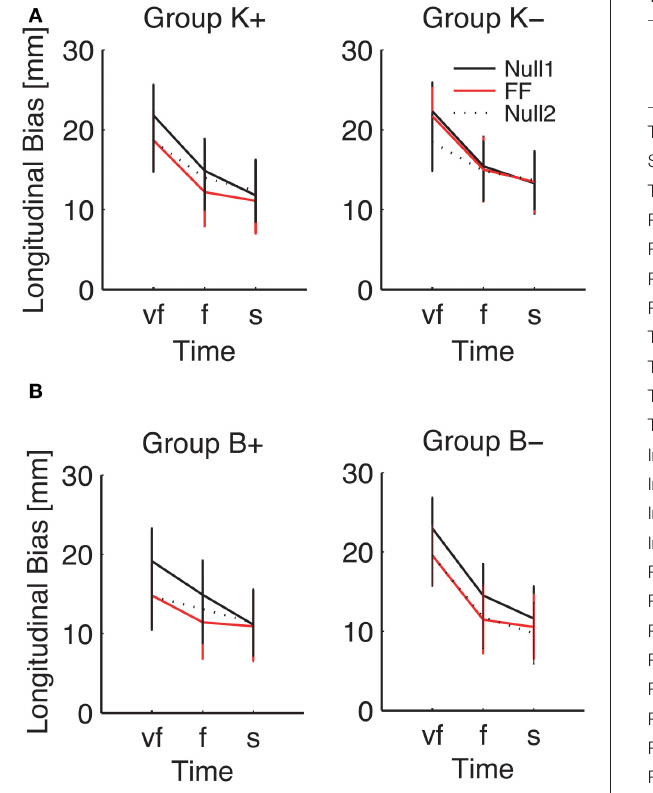
TABLE 3 | ANOVA table for endpoint